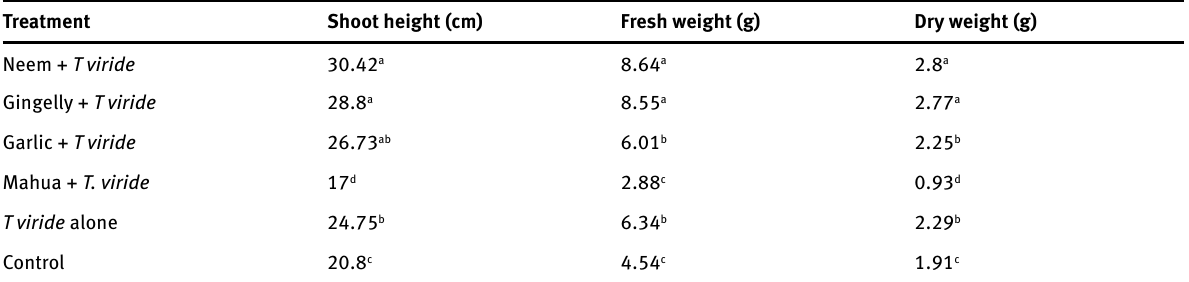
Table 5: Effect of oil cakes and garlic based T. viride preparations in biomass production Treatment Shoot height